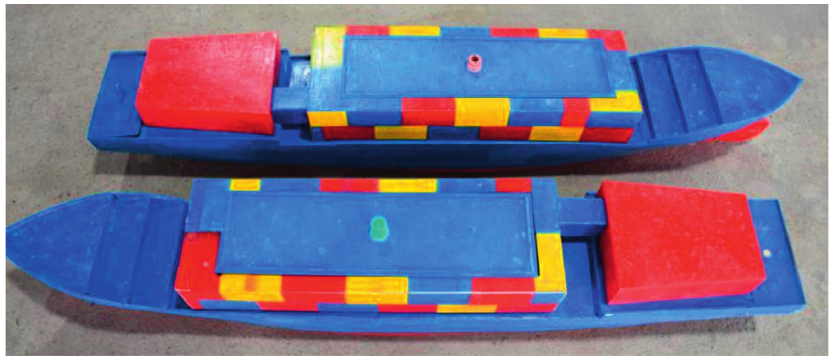
Figure 3: Ship model.